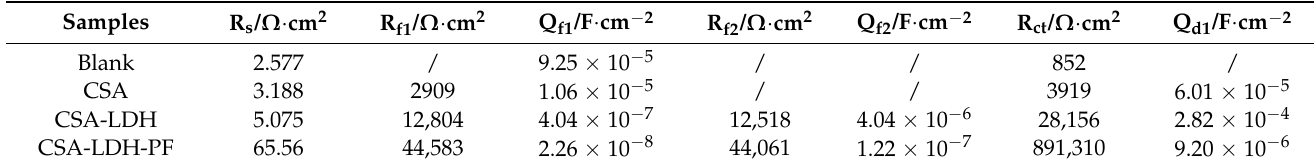
Figure 9. Equivalent circuit fitting diagrams of the ( a ) Blank, ( b ) CSA, and ( c ) CSA-LDH and CSA- LDH-PF samples. R S : solution resistance, R f : film resistance, Q f : capacitance of native oxidized film/passivated film, R ct : charge transfer resistance, Q dl : double layer capacitance.